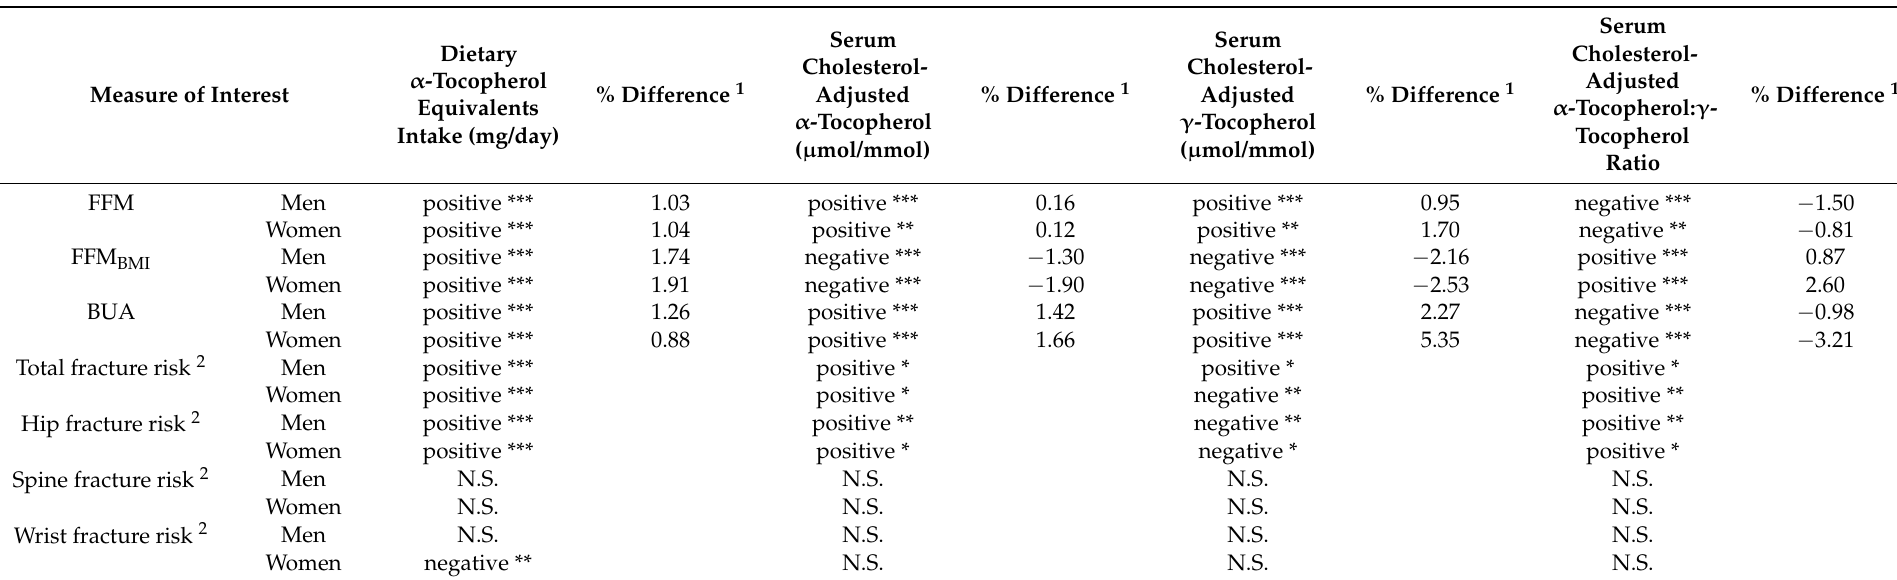
Table 9. Summary of the associations of dietary intake and plasma concentrations of vitamin E with SMM, BUA and fracture risk.